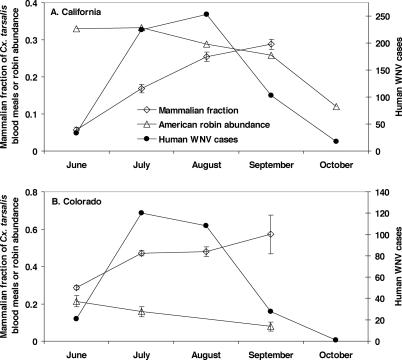
Cx. tarsalis Feeding Patterns, Avian Population Dynamics, and West Nile Virus EpidemiologyFraction of
Cx. tarsalis feedings from mammals (±1 SE), abundances of American robins [birds/survey in (A), birds/hectare ±1 SD in (B)], and the number of human WNV cases in 2004 in California (A) and Colorado (B).